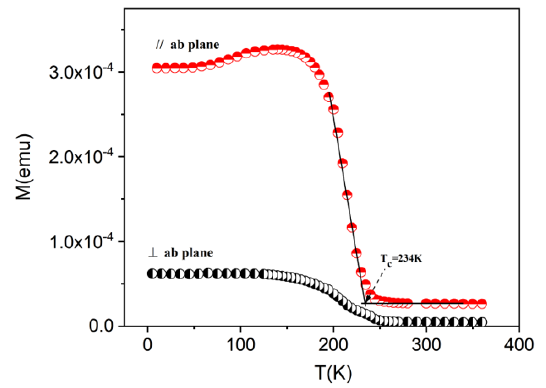
Figure 2. Plots of the field-cooled magnetization versus temperature of a LBMTO-5 thin film, meas- ured under a magnetic field of 0.01 T parallel and perpendicular to the ab plane.